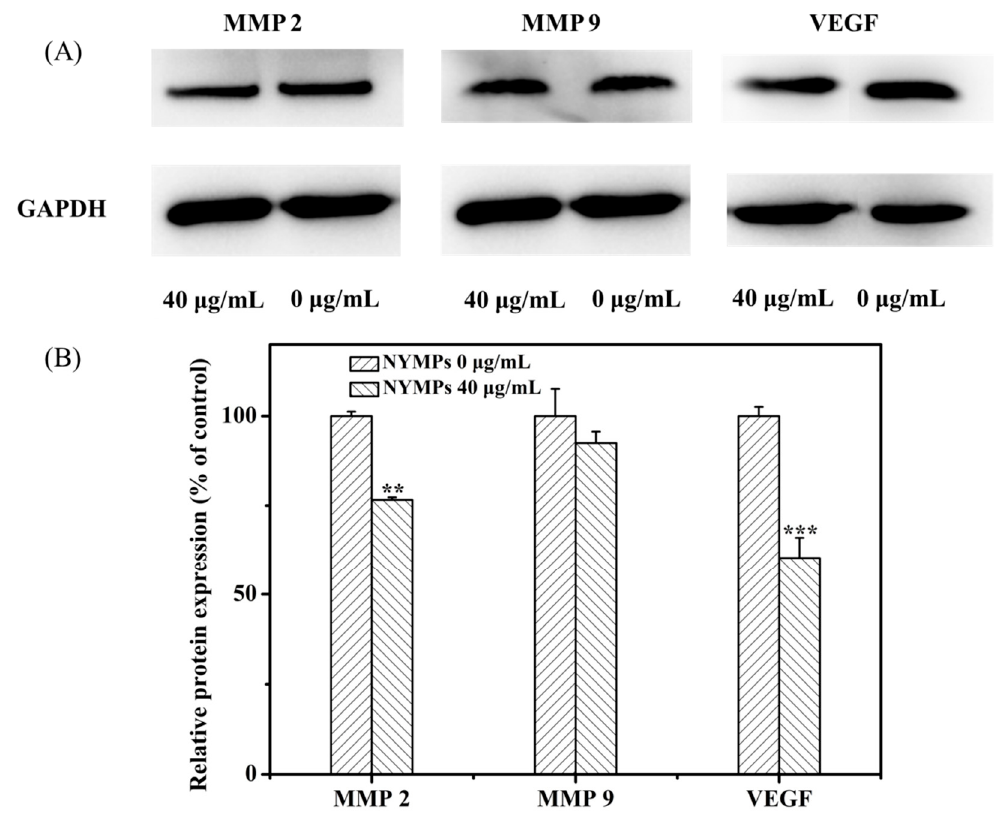
Figure 6. Effects of NYMPs on protein expression level of MMP-2, MMP-9, and VEGF. ( A ) Expression of MMP-2, MMP-9, and VEGF, GAPDH (Glyceraldehyde-3-phosphate dehydrogenase) as loading control; ( B ) Densitometric analyses of (A). Each value represents the mean ± standard deviation ( n = 3). ** p < 0.01, *** p < 0.001 indicated statistically significant differences versus control group.